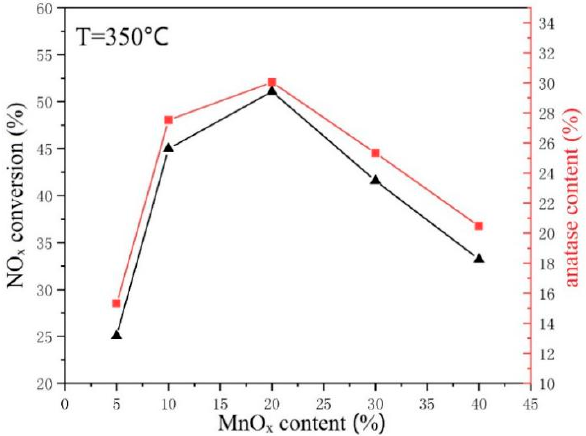
Figure 8. The dependence of the NO x conversion efficiency on the MnO x content and the anatase content.